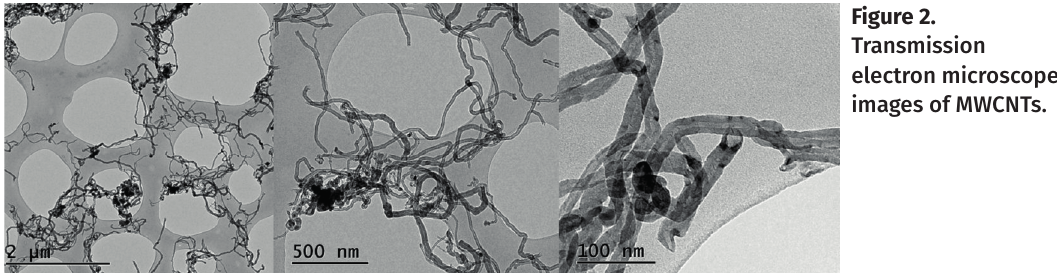
Table III. The chemical admixtures’ most relevant properties. Comercial Based on: Chemical structure of the main component Admixture